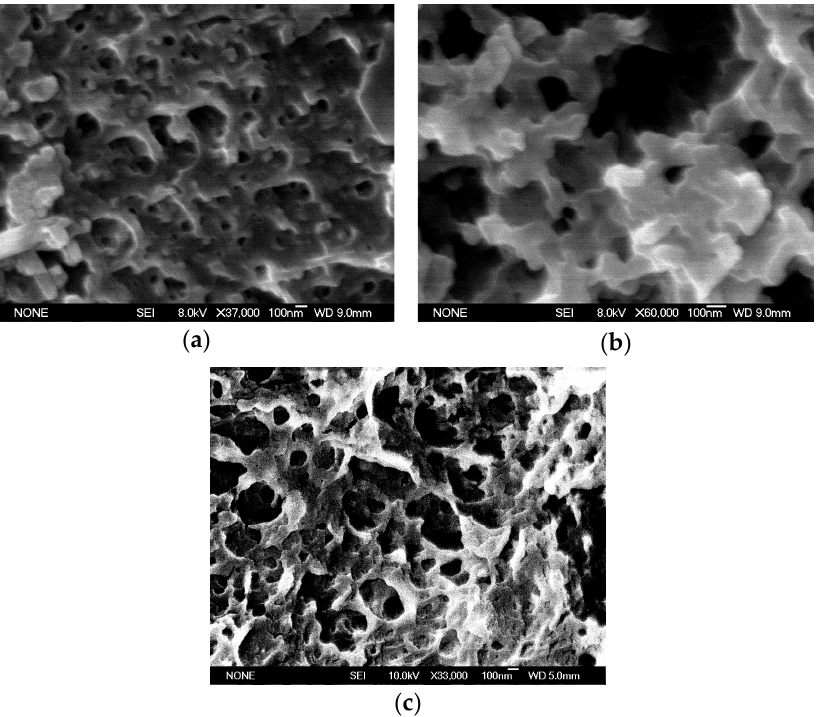
Figure 3. SEM images of porous semi-IPNs after the PMMA removal: ( a ) 2 NRM 55 ; ( b ) 2 NRLM 50 ; ( c ) 0.8 NRM 65